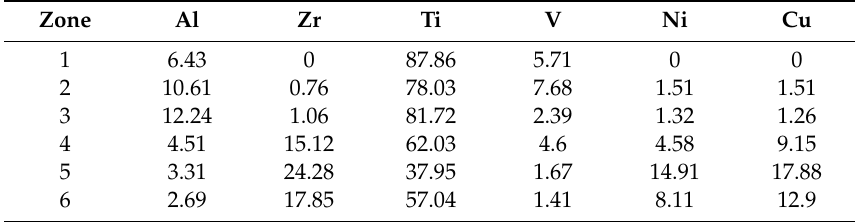
Table 2. SEM EDS chemical compositions (at.%) of the selected locations in Figure 4.